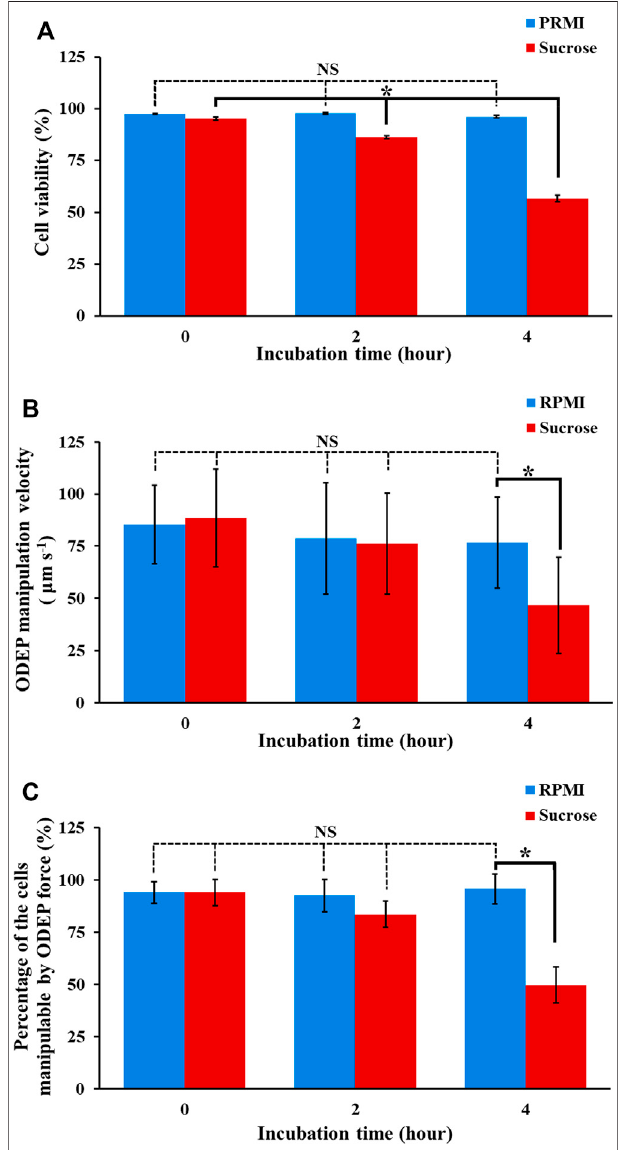
FIGURE3| The (A) cellviability, (B) ODEPmanipulationvelocity,and (C) percentage of the cells manipulatable by ODEP force of the PC-3 cancer cells treated with RPMI culture medium and sucrose solution (9.5%) for 0, 2, and 4 h. The results are presented as the mean ± standard deviation of at least 3 separate experiments. [NS, no signi fi cance and *, signi fi cant difference ( p < 0.05)].